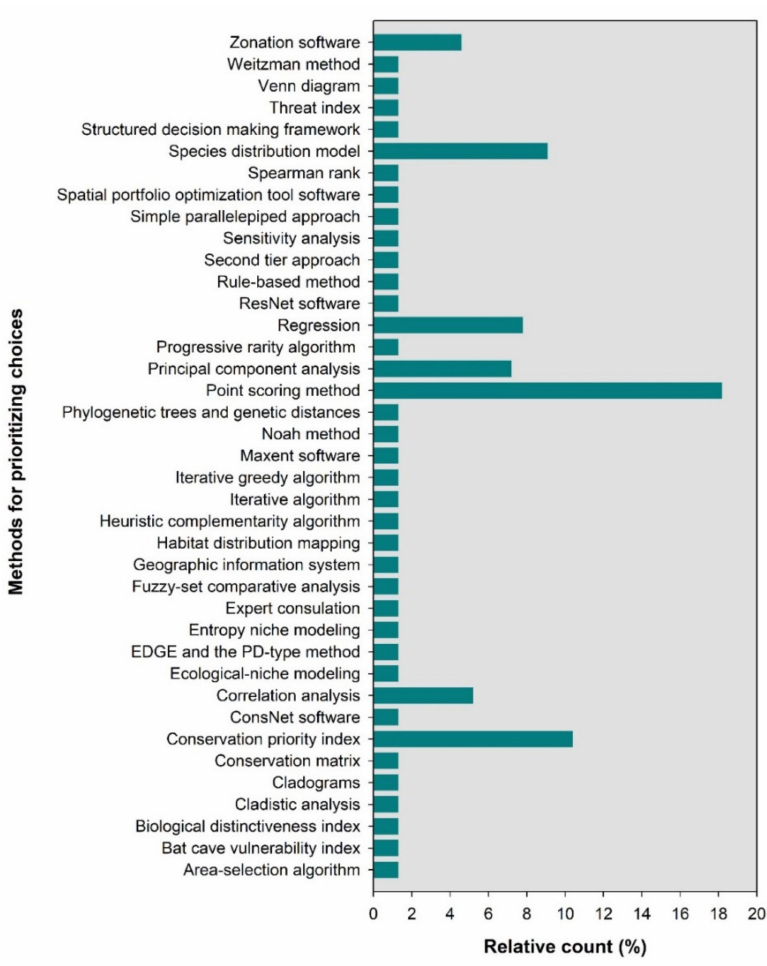
Figure 4. Relative count of the identified methods for prioritizing conservation choices for fauna species.